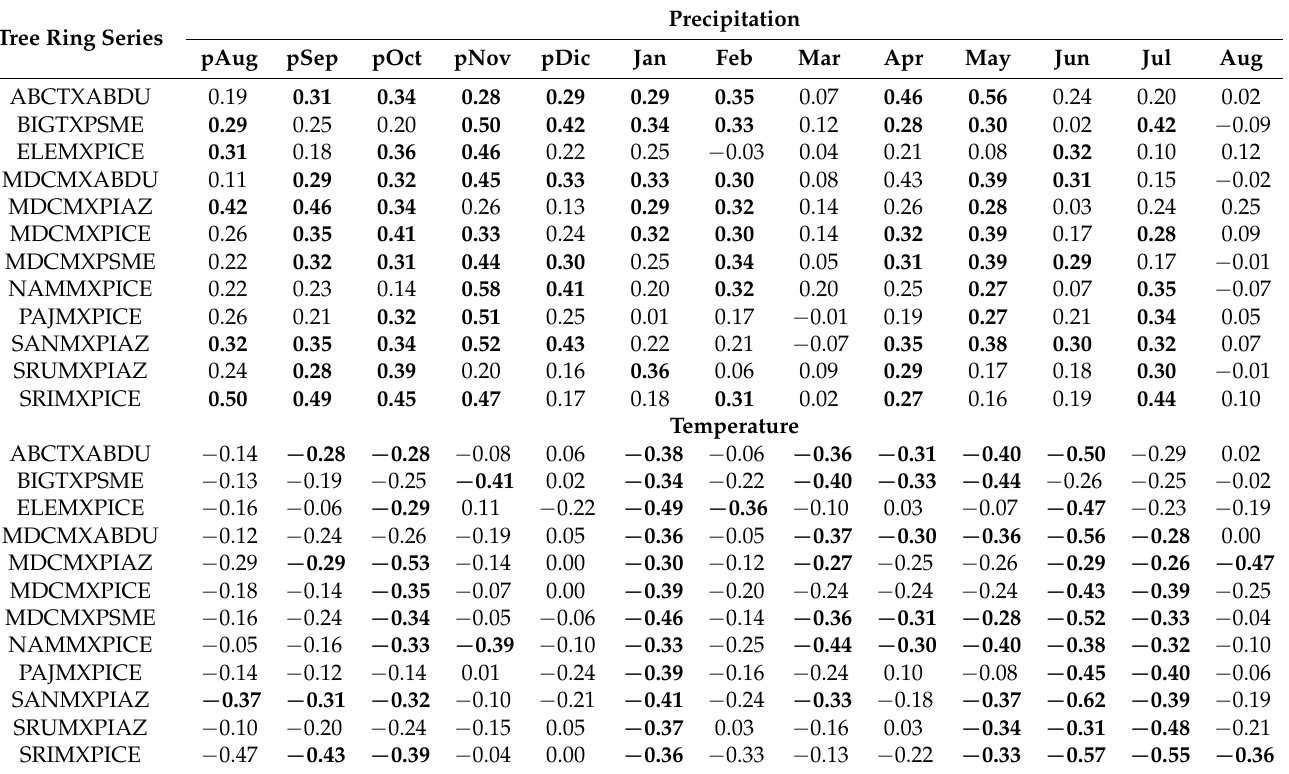
Table 5. Correlation coefficients computed between each tree-ring chronology and monthly pre- cipitation and temperature data averaged for the study. All correlations were computed for the period 1946–2000 when the instrumental climate and the 12 tree-ring chronologies are most strongly replicated. Correlation values in bold are significant ( p <